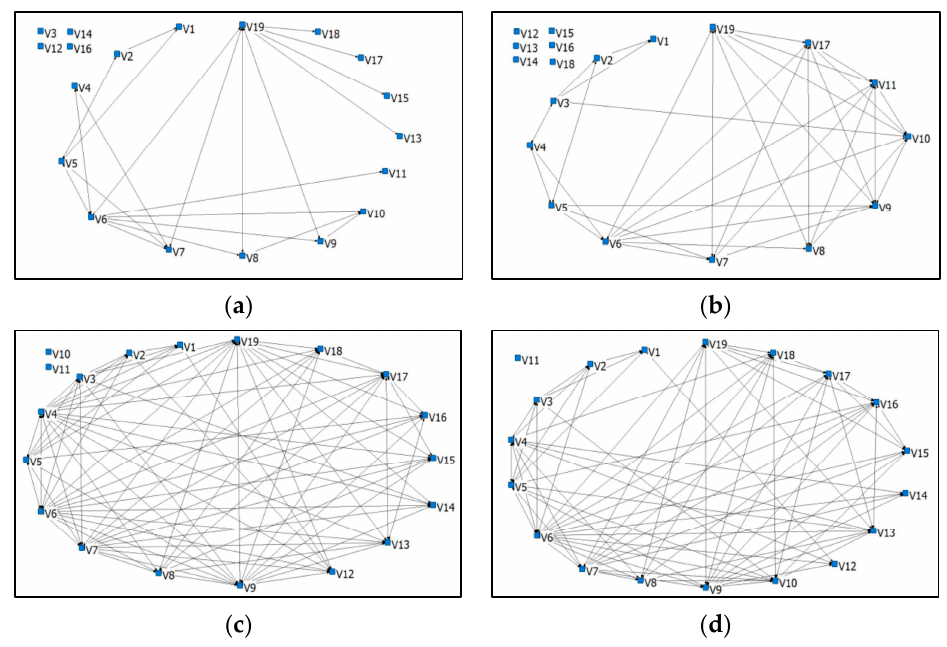
Figure 3. Cooperative relationship networks in four waves: ( a ) wave 1, ( b ) wave 2, ( c ) wave 3, ( d ) wave 4.